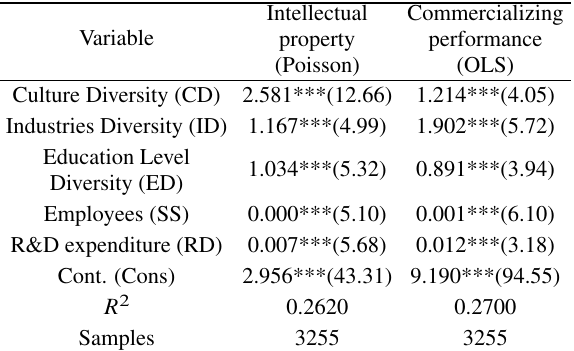
Table 2 Regression results of diversity and innovation. A survey of all Chinese startups in government-sponsored incubators, showing that cultural diversity is the biggest factor in successful launch and funding of startups [26] .